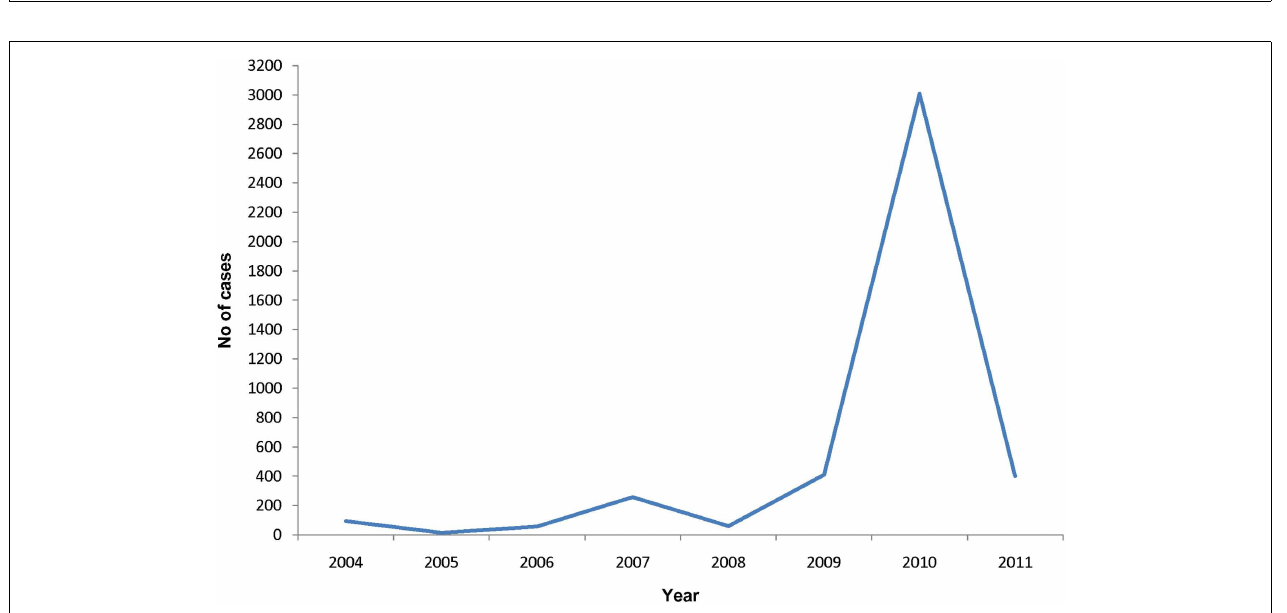
FIGURE 4 | Number of malaria cases in the period 1983–2011 in the Jaffna district. Data from the Anti-Malaria Campaign of the Ministry of Health, Jaffna.